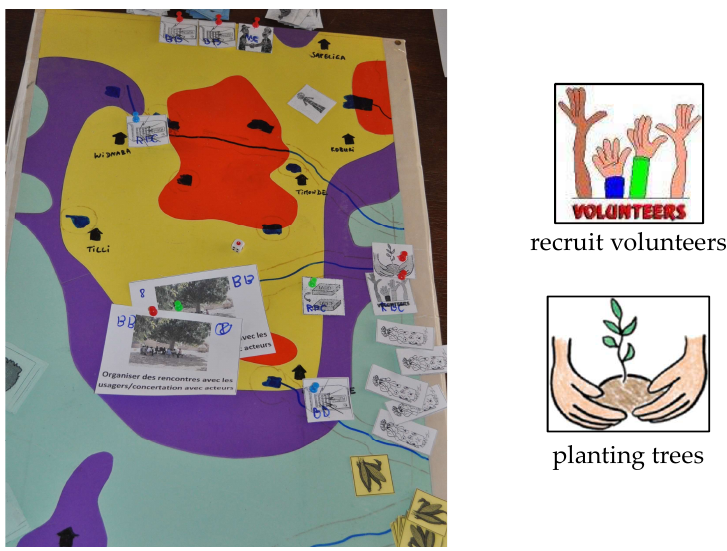
Figure 5. Bushbank board game ( left ), similar to Bawkudo (here the right bank of the White Volta River) and two examples of stickers ( right ) representing activities district players locate on the board.